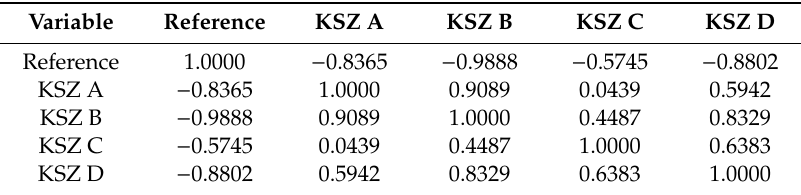
Table 10. The correlation coe ffi cient of tensile modulus obtained in various ageing variants under thermal shock conditions and in the reference condition (for significance coe ffi cient p < 0.05).